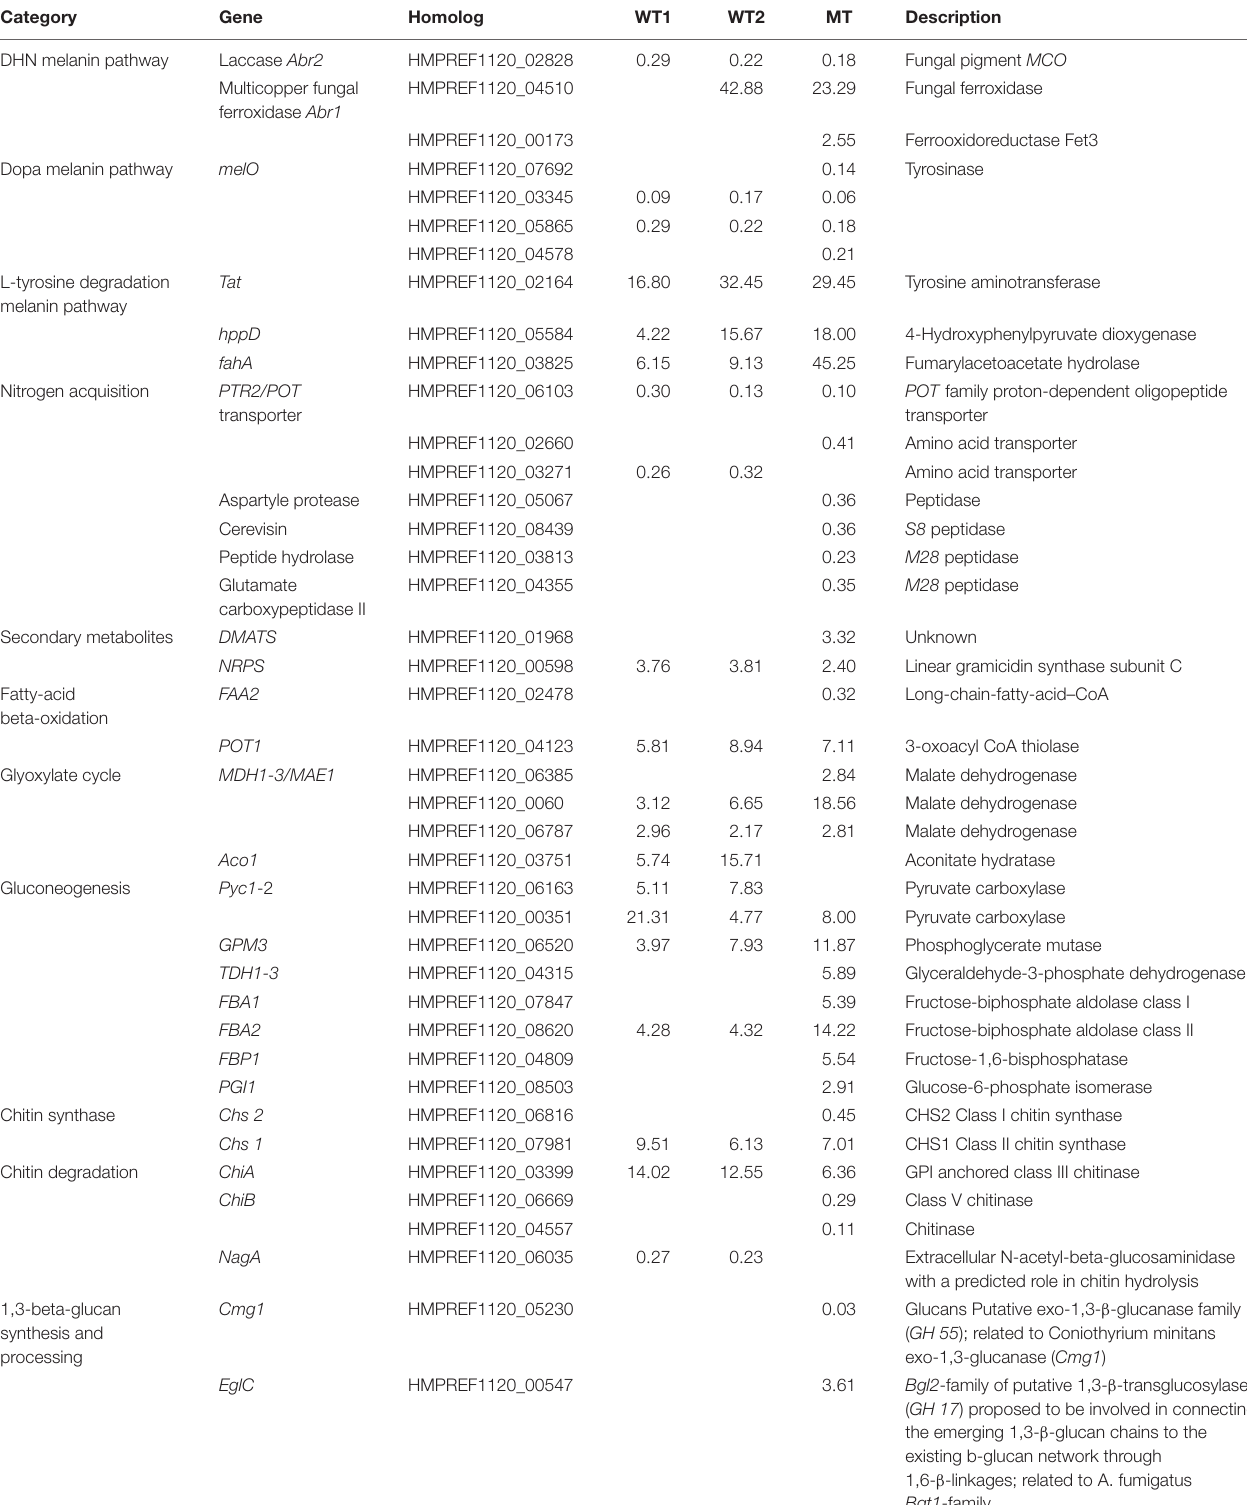
TABLE 1 | List of genes involved in melanin production, nitrogen/carbon/metal acquisition, secondary metabolites production and cell wall regulated either differently in wild-type 1 (WT1), (Poyntner et al., 2016), wild-type 2 (WT2) and mutant (MT) or in all three experiments.